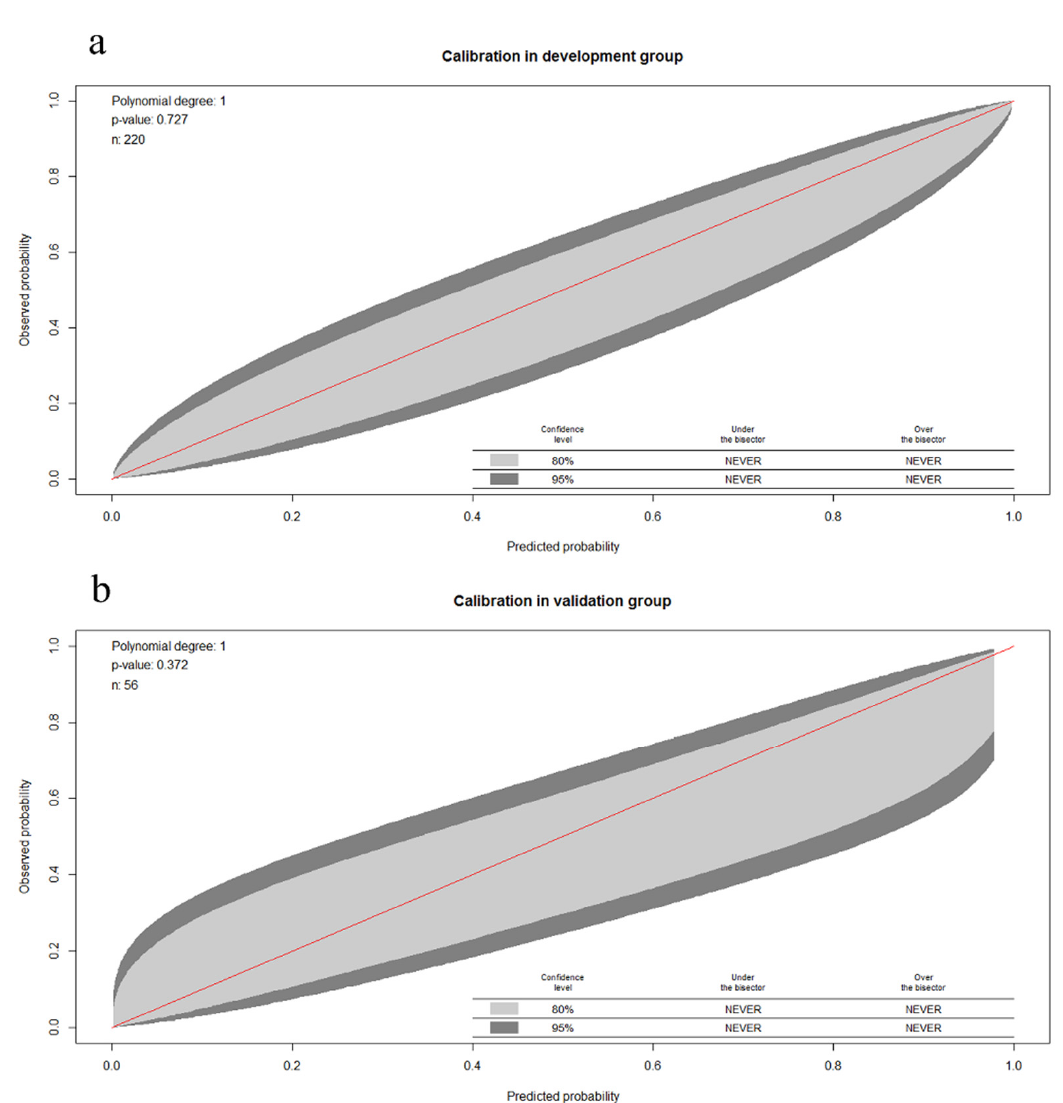
Figure 5. GiViTI calibration belt used to estimate the calibrating ability of the prediction model. ( a ) Model construction group; ( b ) validation group. GiViTI, Gruppo Italiano per la Valutazione degli Interventi in Terapia Intensiva.